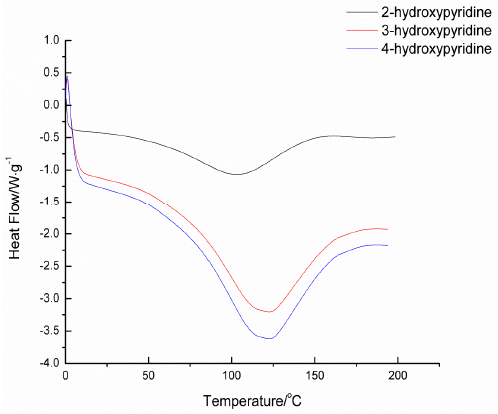
Figure 2. DSC thermograms of blocked isocyanates.